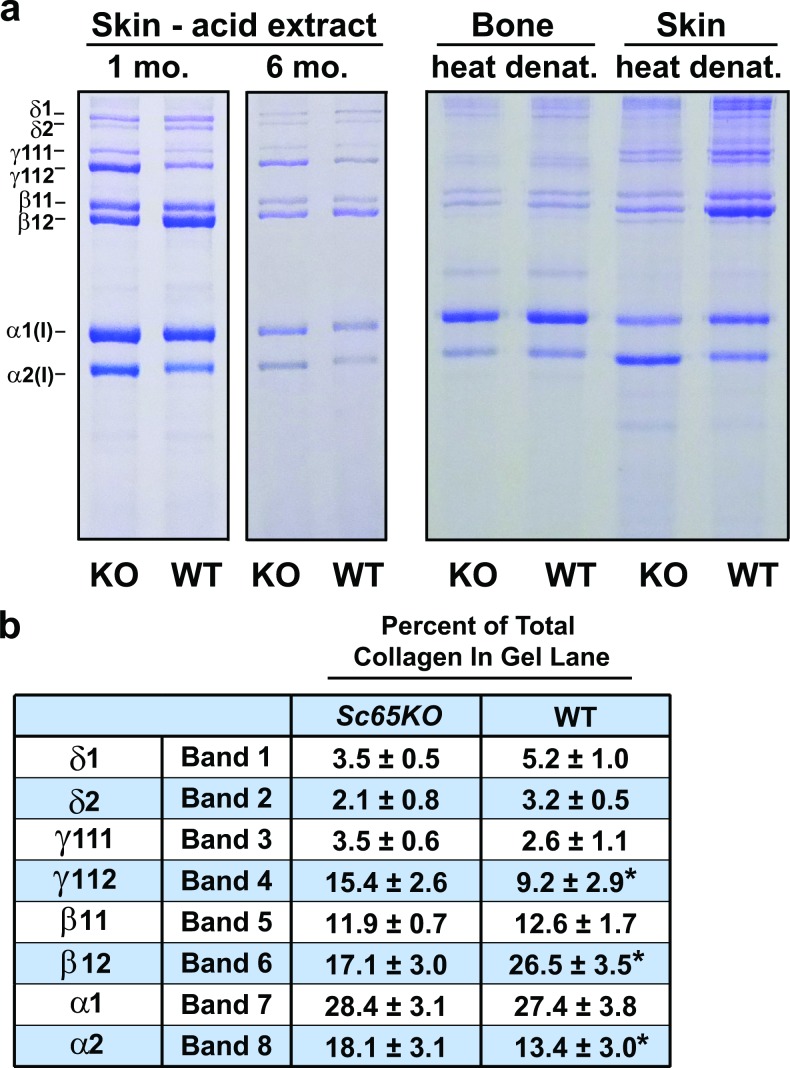
Increased electrophoretic mobility and altered cross-linking of type I collagen from Sc65-null skin.a) SDS-6%PAGE of type I collagen extracted from skin and decalcified bone of Sc65KO and WT mice shows increased mobility of α-chains and reduced ratio of cross-linked β to γ components in the Sc65KO skin extracts. An acetic acid extract from skin of the original Sc65-null mouse19 (1 mo.) created by gene-trap insertion is compared with that from the new Sc65KO (6 mo.) and their respective WT controls. Total heat denatured extracts of skin and bone collagens from new Sc65KO mice are shown on the right for comparison. Bone collagen from Sc65KO mice does not show the differences from WT in β/γ intensities evident for skin collagen. The strong (lower) γ band in SC65 skin extracts was identified as γ 112. Both original and new Sc65KO mice showed the same altered pattern of chain intensities from WT most pronounced in the acetic acid extracts of skin with an apparent increase in γ112 at the expense of β12. b) Densitometric analysis of collagen bands on SDS-PAGE. Densitometry was performed on bands 1–8 (counted from top to bottom) of acetic acid extracts from 1mo and 6mo skin samples of both original and new Sc65KO mice using NIH imageJ software. Values are means ± SD, n = 6; *p<0.01.